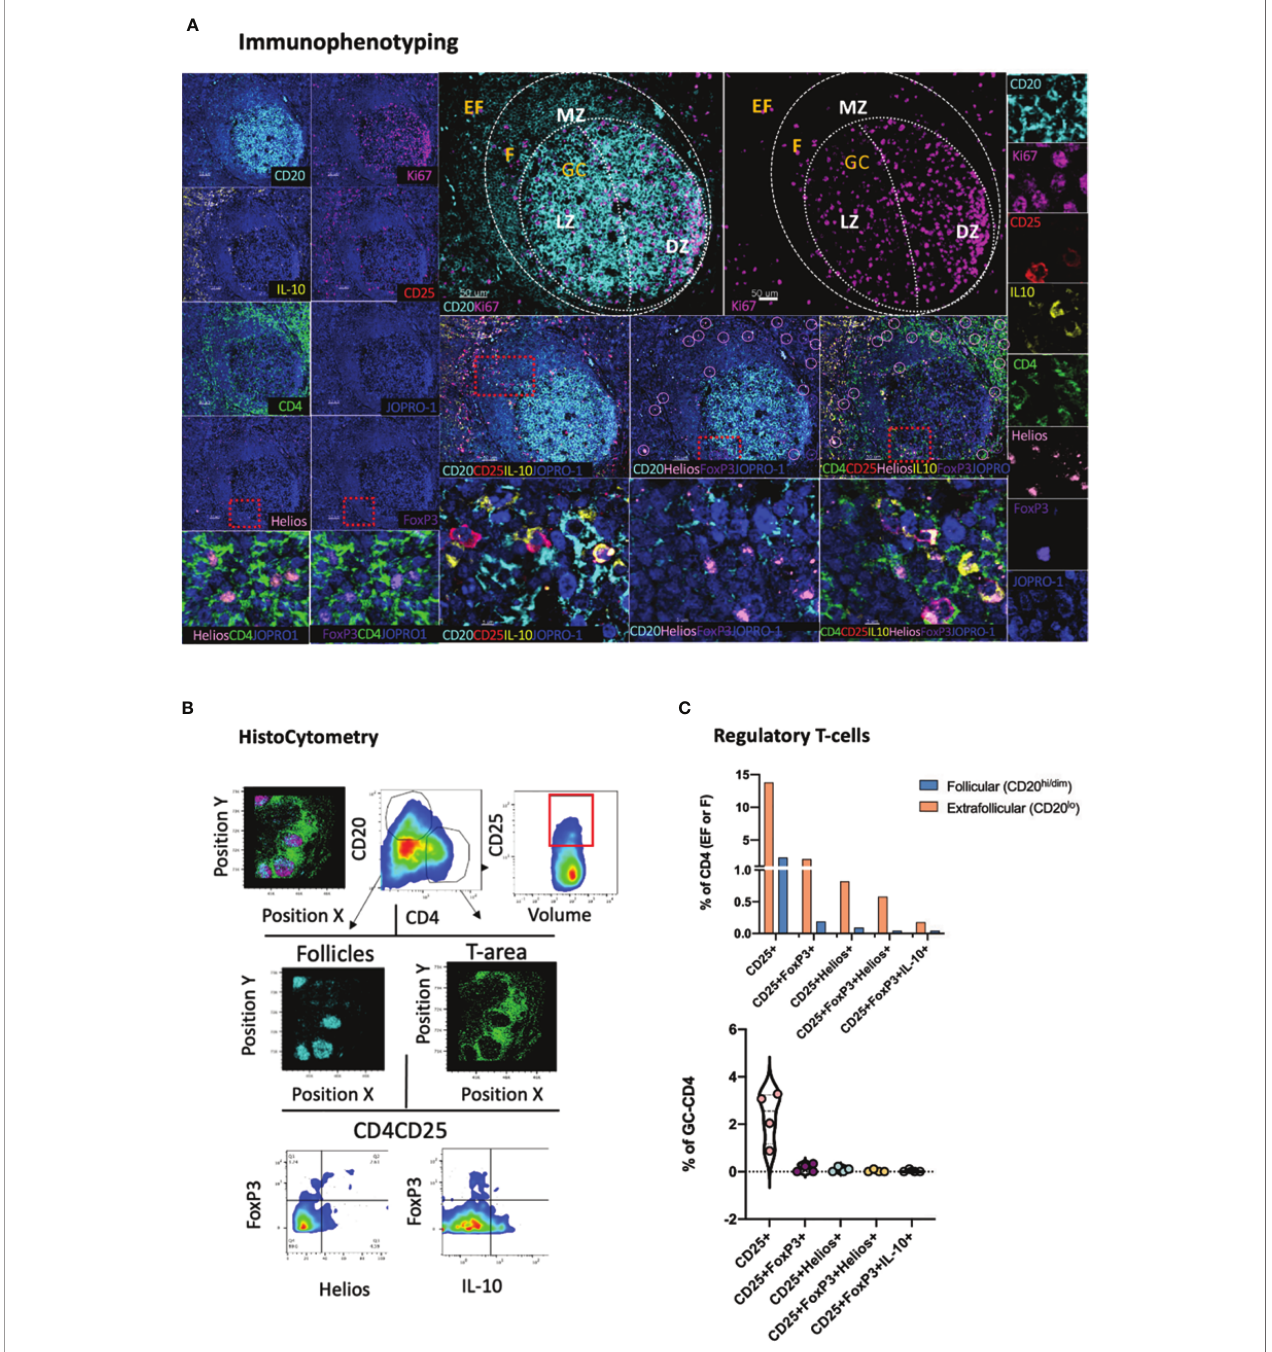
FIGURE 2 | Development of a multispectral panel for the assessment of tissue-speci fi c T-cell regulation. (A) Representative example of antibody staining patterns for Helios (pink), CD20 (cyan), CD25 (red), IL-10 (yellow), Ki67 (magenta), CD4 (green) and FoxP3 (purple) in a tonsillar tissue section (left and right panels) and distribution of each marker with respect to the MZ, LZ and DZ (middle panels). Circles (pink/purple) in lower middle panels denote individual Helios (pink) and FoxP3 (purple) events. (B) Immunophenotyping gating strategy used for the identi fi cation of Tregs and Tfrs in lymphoid tissues of interest based on the expression and coexpression of the transcription factors FoxP3, Helios, the protein marker CD25 and IL10 in histocytometry. (C) Bar graphs (upper row) and violin plots (lower row) showing the frequencies of Tregs and Tfrs in follicular and extrafollicular areas and frequencies of Tfr subsets in a tonsillar tissue section. Circles in violin plots represent individual follicles whereas colors represent different phenotypic subgroups. Images were acquired at 40x (NA 1.3) with 1% magni fi cation. Scale bars are 50um, 10um (zoomed in details) and 5um (Helios and FoxP3 staining patterns)